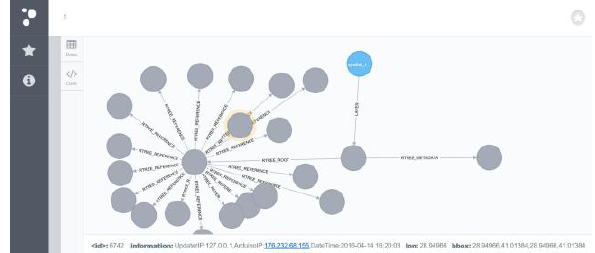
Figure 7: Representation of information stored in Neo4J The third layer of the integration architecture consists of